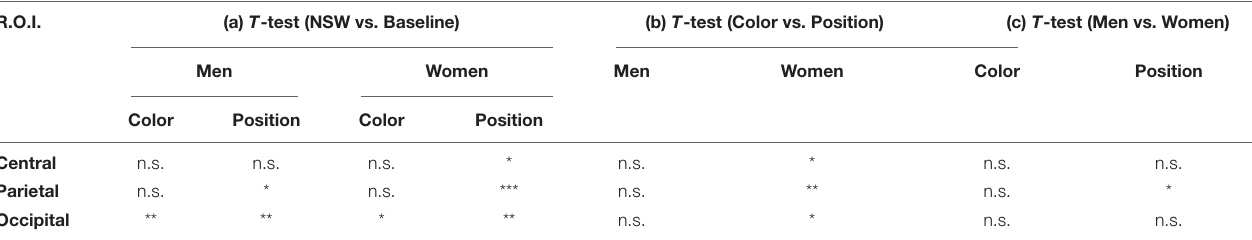
TABLE 2 | p -value obtained by comparing the electrical activity in the negative slow wave (NSW) time window: (a) with the baseline by region of interest (Central, Parietal, and Occipital), criteria (color, position) and sex (men, women); (b) between color and position trials by ROI and sex; (c) between sexes, by ROI and criteria.